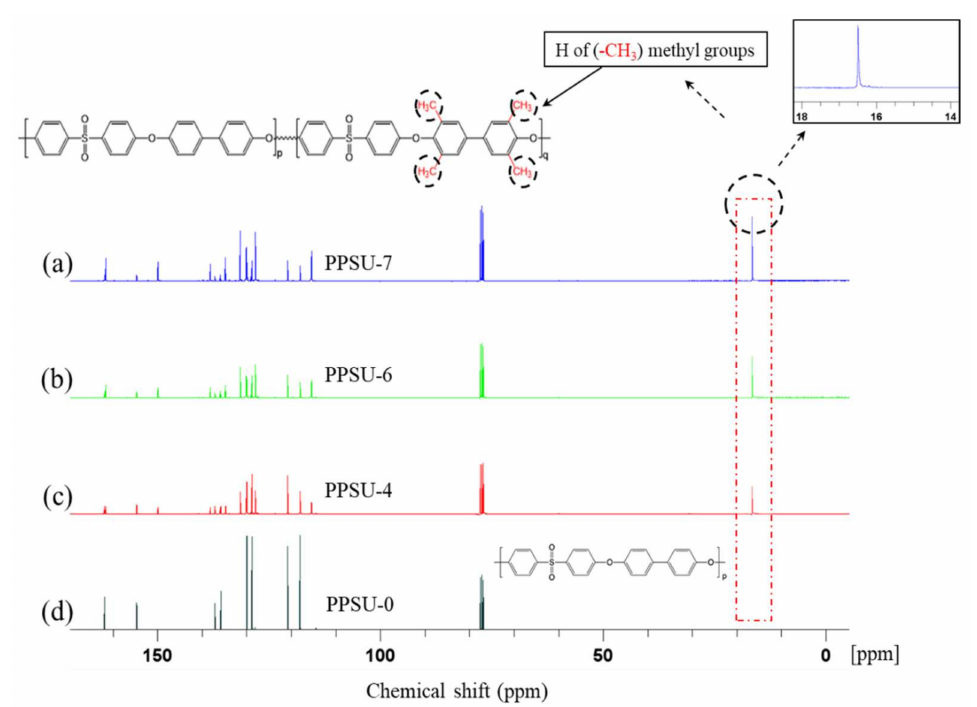
Figure 4. Spectra of 13C NMR of ( a ) PPSU-7, ( b ) PPSU-6, ( c ) PPSU-4, and ( d ) PPSU-0 polymers. The peaks (singlets) around 16.50 ppm in spectra a, b, c reveals 1 type of carbon (C) of symmetric methyl groups on the benzene rings of PPSU-4, PPSU-6, and PPSU-7. PPSU-0, 4, 6 and 7 are related to the TMPPSf mole fractions of 0, 0.46, 0.64 and 0.74, respectively, in copolymers, and the detailed